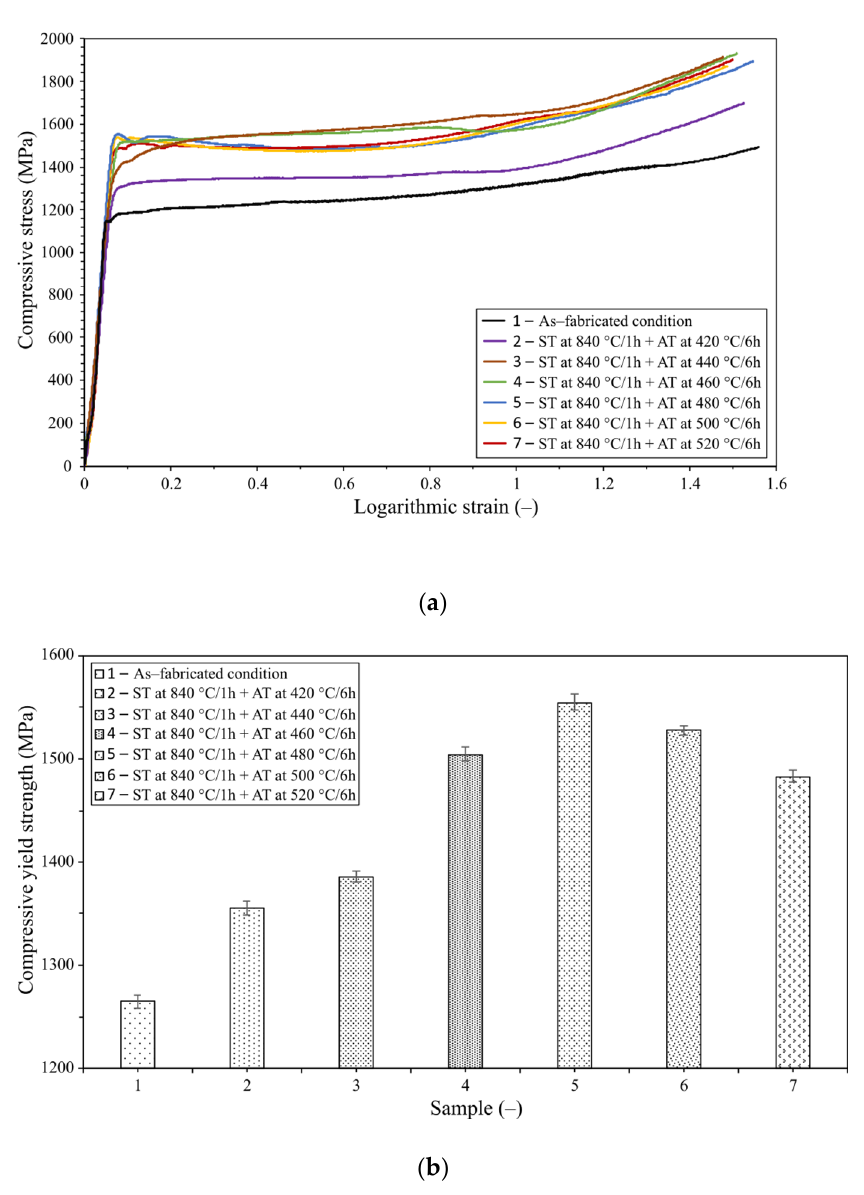
Figure 4. ( a ) Effect of different aging temperatures on compressive stress-strain curves, ( b ) compressive yield strength. For reference, measurements in the as-fabricated state are also included.